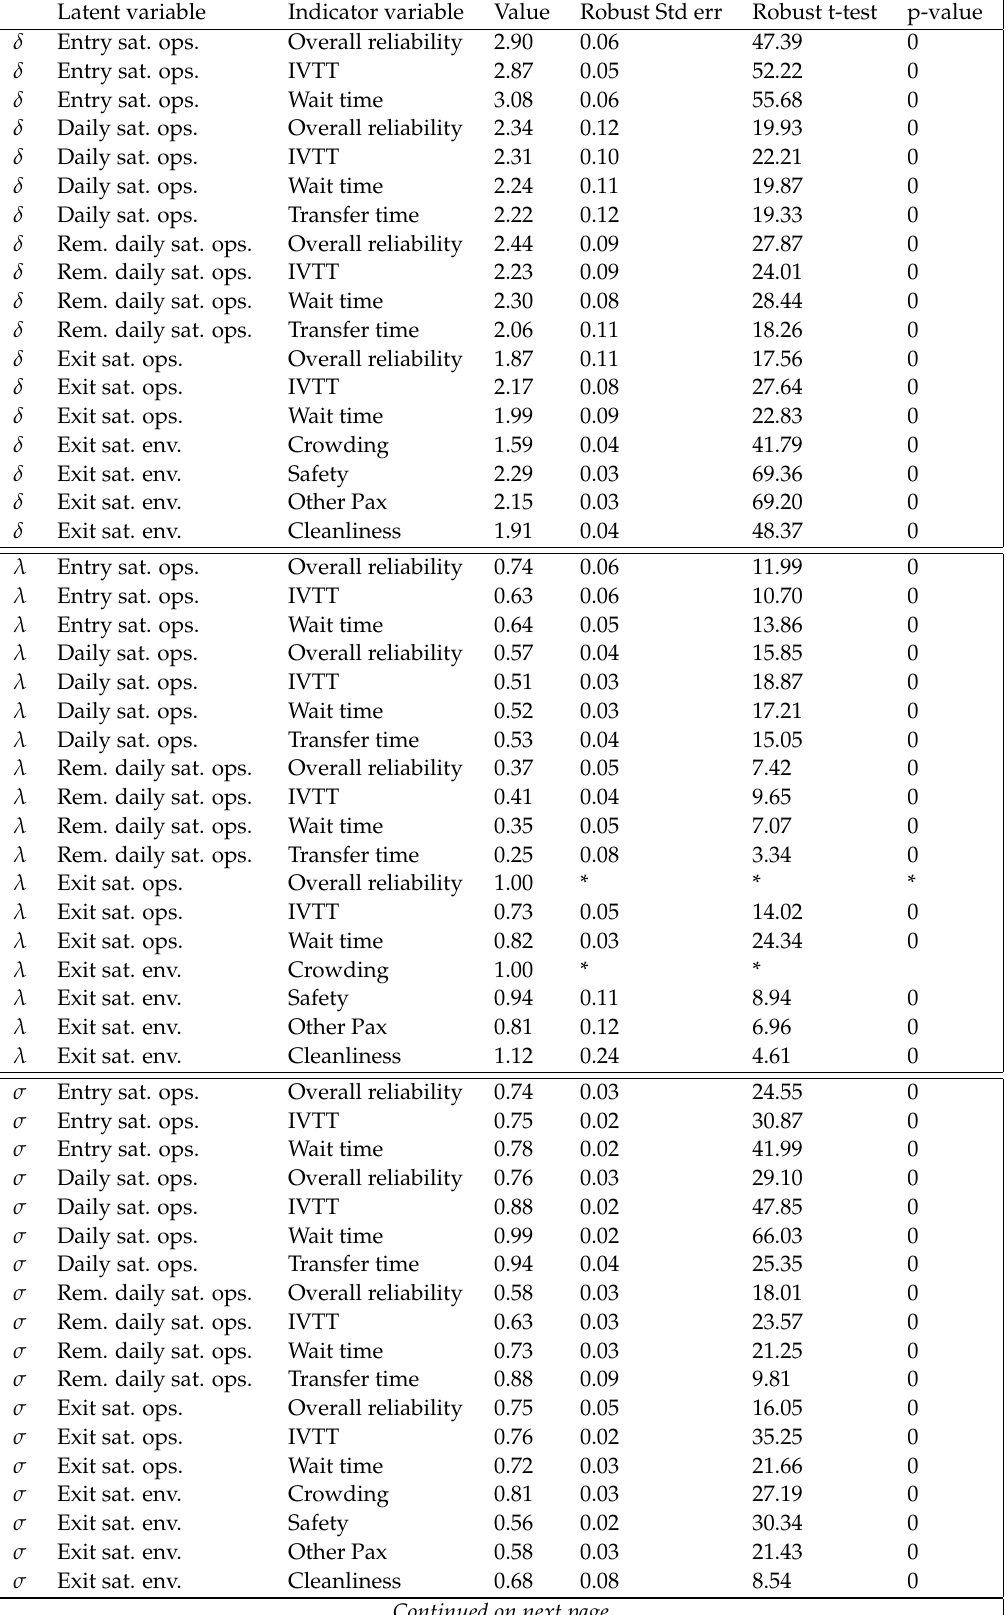
Table 5. Estimation results for the measurement equations of the latent variable choice model. The abbreviations are explained at the end of the